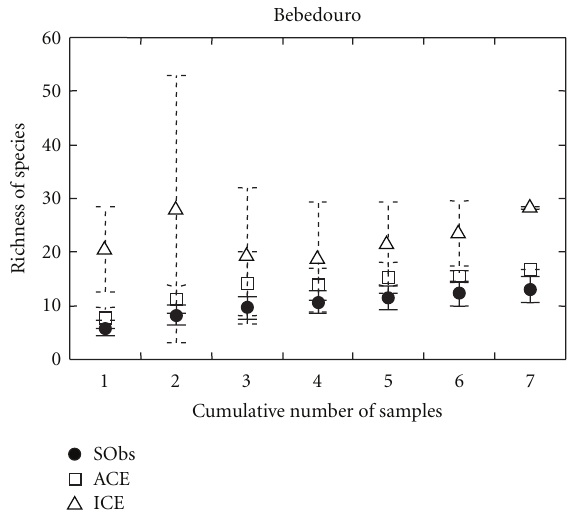
Figure 5: Richness of species observed and estimated using ACE (Abundance-based Coverage Estimator) and ICE (Incidence-based Coverage Estimator) indexes to the area of